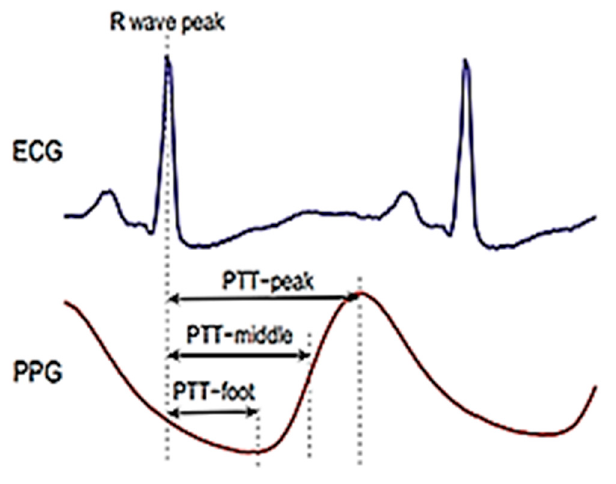
Figure 12. Pulse arrival time (PAT) feature. Table 5. Comparison classification performance of KNN.